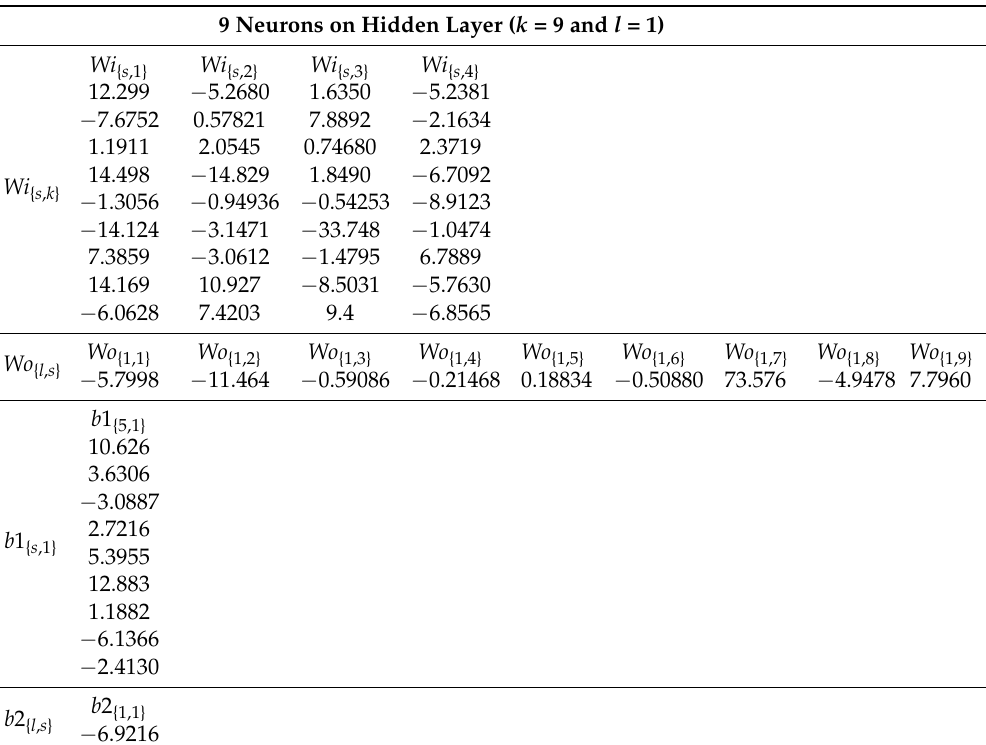
Table A6. Weights and biases for the ANN model predicting 8-oxodG concentration. 9 Neurons on Hidden Layer ( k = 9 and l = 1)